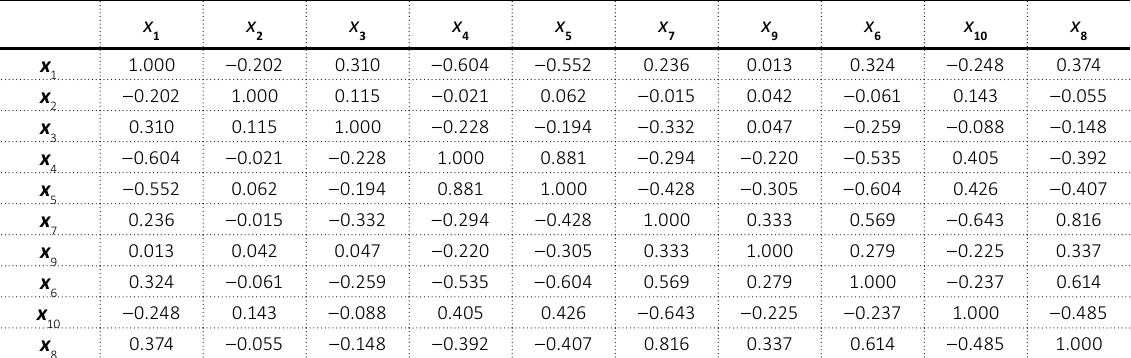
Table 1. Correlation matrix of key indicators of the Ukrainian CSs market development x